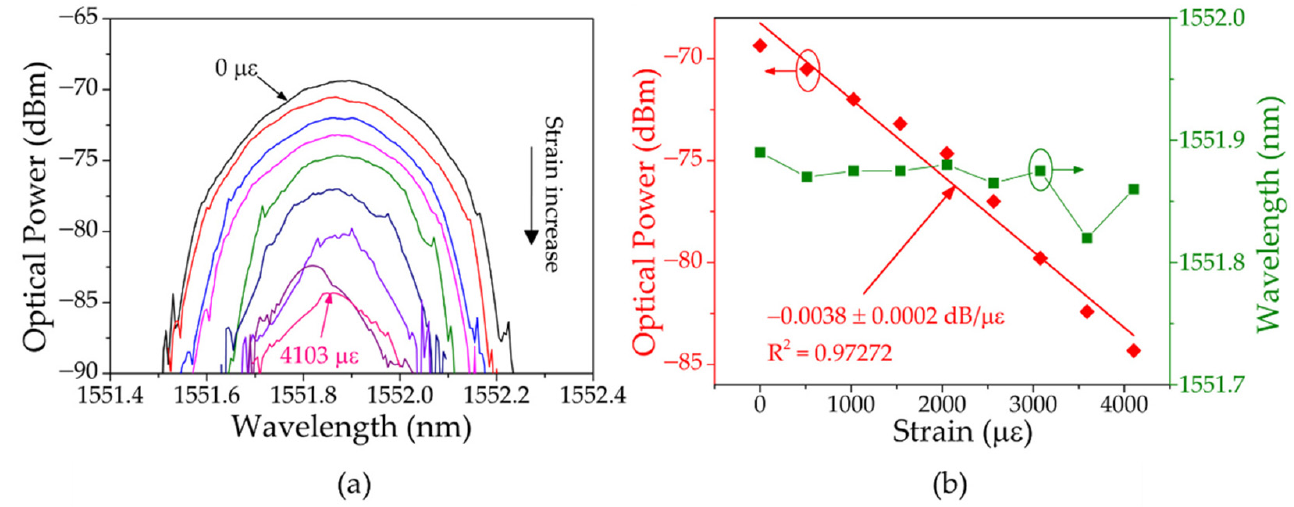
Figure 13. ( a ) Reflection spectra of the resulting signal at different levels of strain on the USPOFBG fiber. ( b ) Corresponding wavelength and optical power shift with increasing